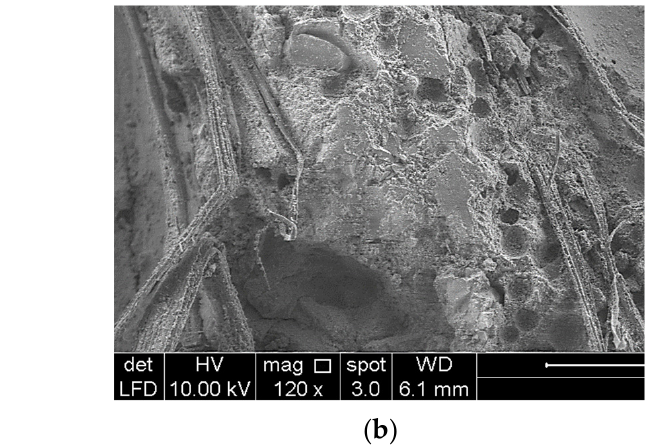
Figure 11. Morphology of ( a ) control specimen; ( b ) foamed concrete with 4% PFF.